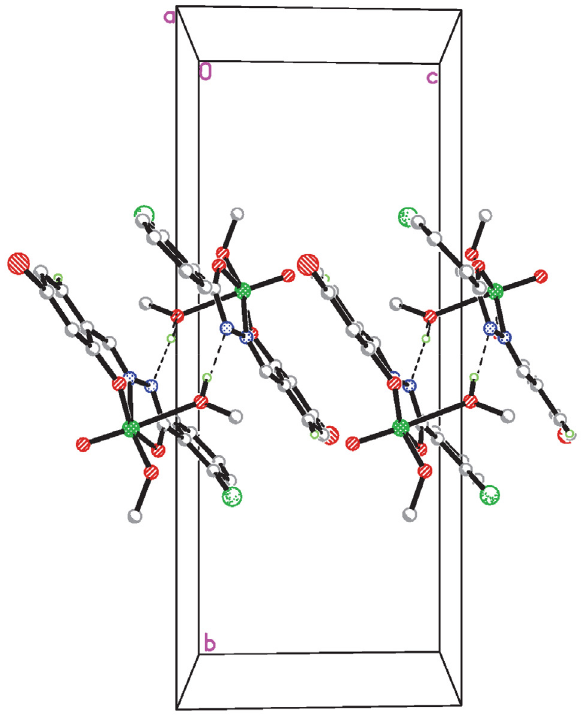
Figure 5. Molecular packing structure of complex 1 , with hydrogen bonds shown as dotted lines.